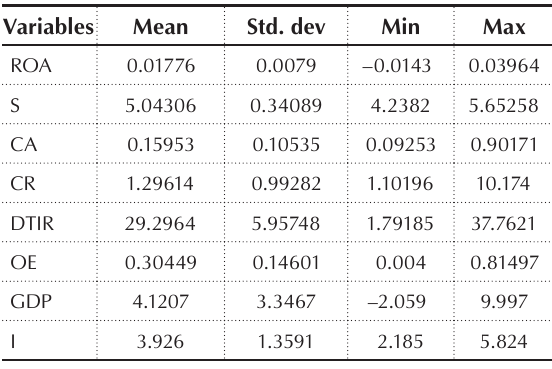
Table 1. (cid:24)(cid:286)(cid:400)(cid:272)(cid:396)(cid:349)(cid:393)(cid:415)(cid:448)(cid:286)(cid:3)(cid:400)(cid:410)(cid:258)(cid:415)(cid:400)(cid:415)(cid:272)(cid:400)